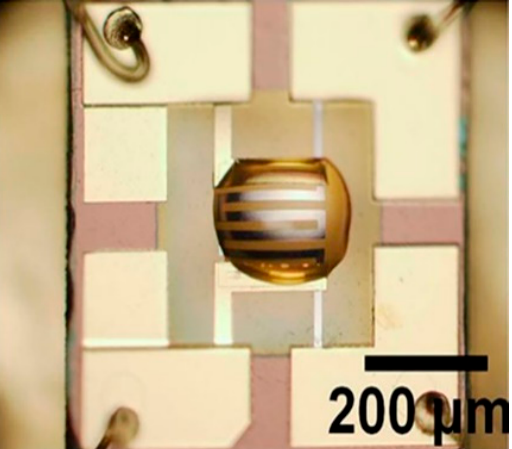
Figure 20. Inkjet printing of an optical image of SnO 2 nanoparticle ink deposited on a micro-hotplate